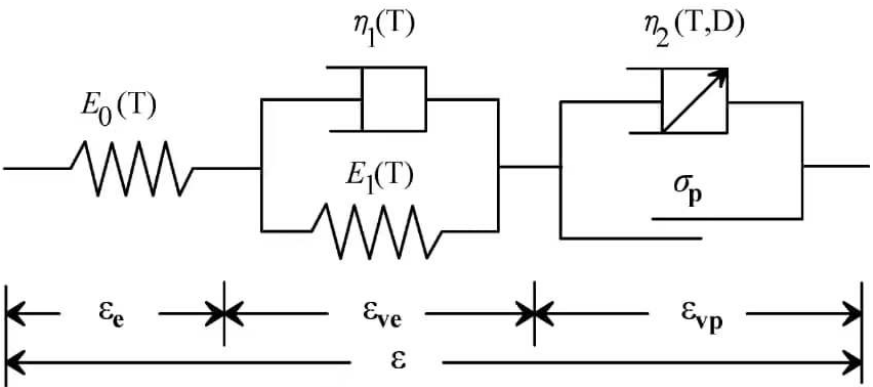
Figure 9. A mechanical model integrating thermo-damage effect (after Chen et al. [97], Copy- right©2022, with permission from the publisher, License No. 5333771474409).